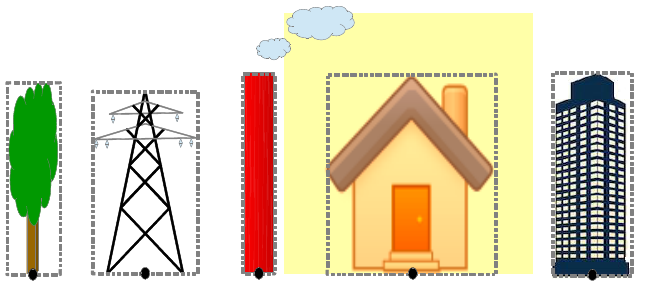
Figure 2. Examples of reference point selection for various